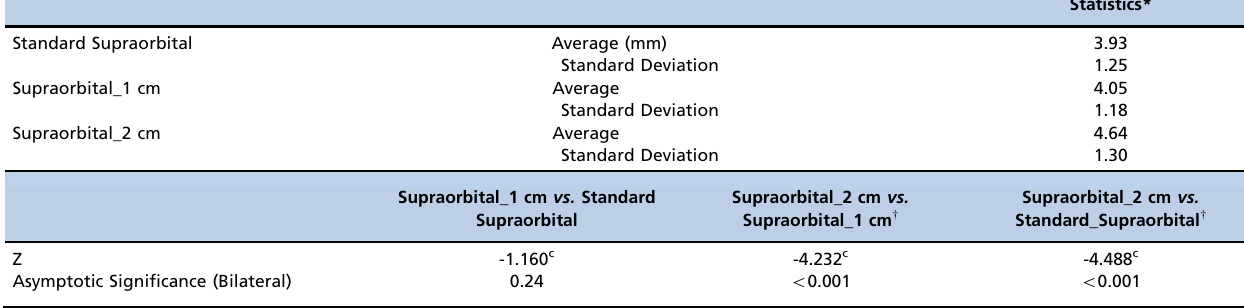
Table 3 - Supraorbital pin comparison between children 6 and 12 years of age.